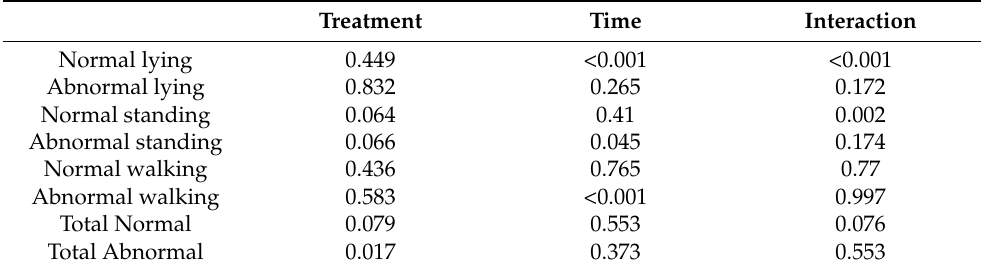
Table 5. Table of p values of model terms for behaviour data analysis using generalised linear mixed model (glmer) with binomial proportions. Fixed effects were Treatment and Time, with a random term of Lamb included. The model looked at treatment, time and their interaction. Treatment groups are as follows: castration + analgesia (CML), castration (C), and sham control